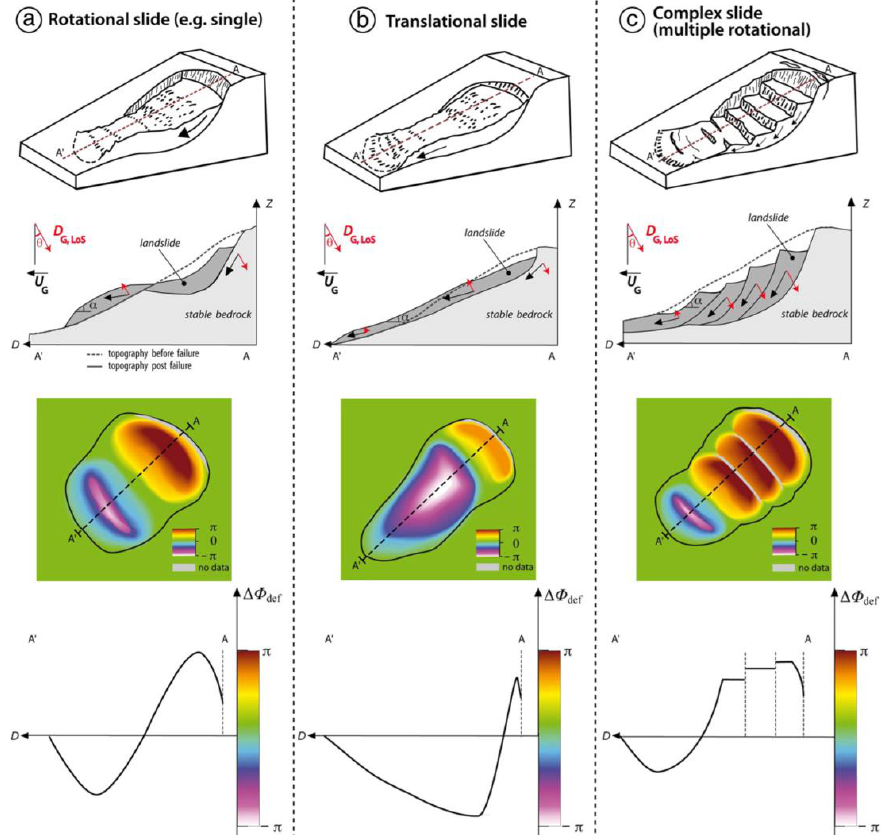
Figure6. Displacementpatterns, morpho-structures, andassociatedinterferometricphasefor3landslide Figure 6. Displacement patterns, morpho-structures, and associated interferometric phase for 3 types (Adapted from landslide types (Adapted from [47]).